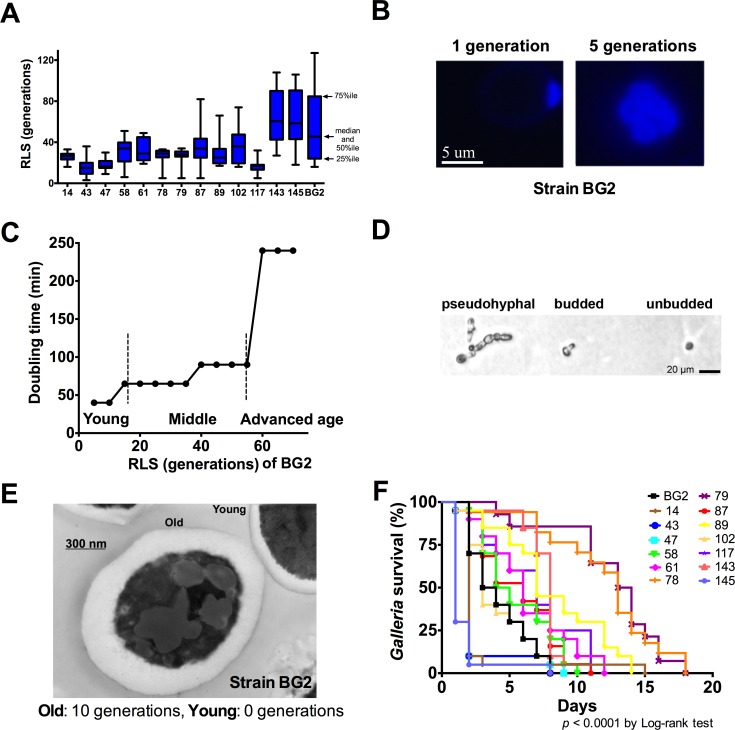
Phenotypic characterization of RLS in C. glabrata.(A) A box-and-whiskers plot demonstrates significant variability in RLSs of C. glabrata strains, shown as box plots with percentiles (n = 20 cells per experiment and 2–6 experiments compared by Log-Rank test). (B) Calcofluor stain reliably identifies generational age of C. glabrata (n = 100 cells). (C) Distinct doubling times during different lifespan phases, and (D) various cell morphologies were captured at time of death. (E) shows thicker cell wall in older BG2 cells by TEM (n = 100 cells compared by Student’s t-test). (F) C. glabrata demonstrated variable virulence in G. mellonella (n = 20 worms compared by Log-Rank test).